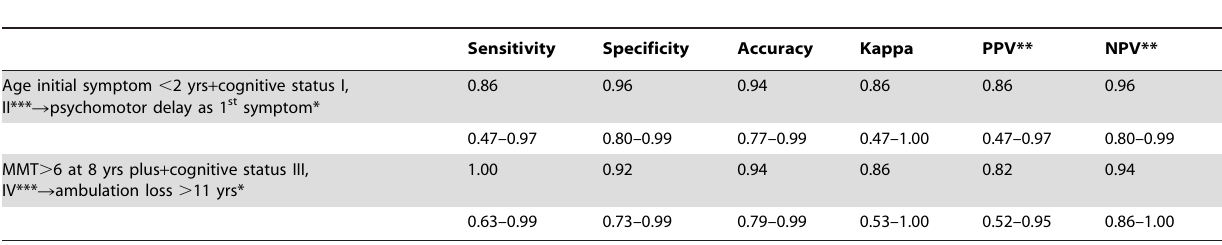
Table 5 . Simplified indicators applied to congenital and to moderate pure motor DMD in series